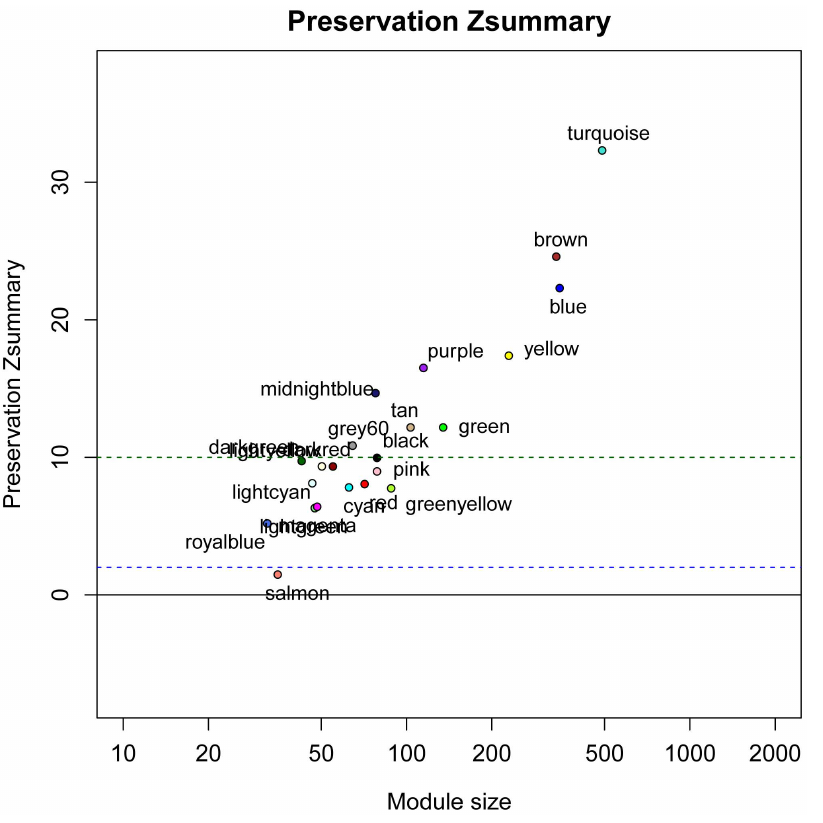
Figure 2. Composite preservation statistics of PHNet modules in SONet. The summary statistic Z summary (y-axis) as a function of the module size, Each point represents a module, labeled by color. The blue and green horizontal lines show the thresholds of Z summary ~ 2 and Z summary ~ 10 , respectively. Z summary w 10 shows a strong evidence of preservation and Z summary v 2 shows no evidence of preservations. 2 v Z summary v 10 shows a weak evidence of